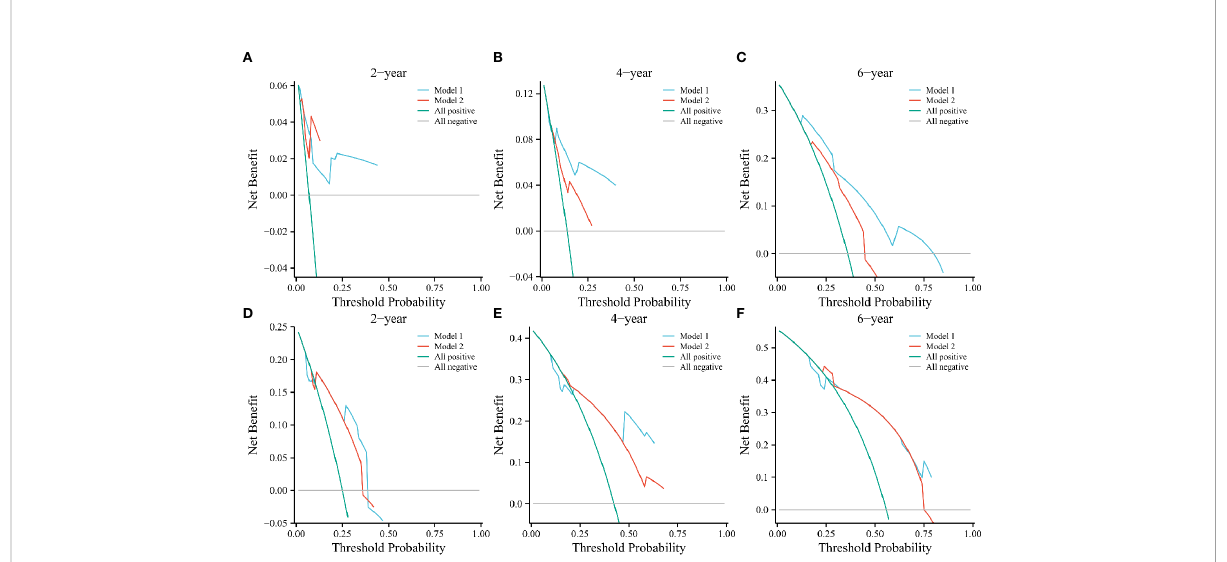
FIGURE 2 Decision curve analyses of Models 1 and 2 at 2, 4, and 6 years in the training (A – C) and validation cohorts (D – F) . The green and gray line indicates that all patients were dead or alive, respectively. The blue and red line indicates the clinical net bene fi t of Model 1 and 2 at different threshold probabilities.